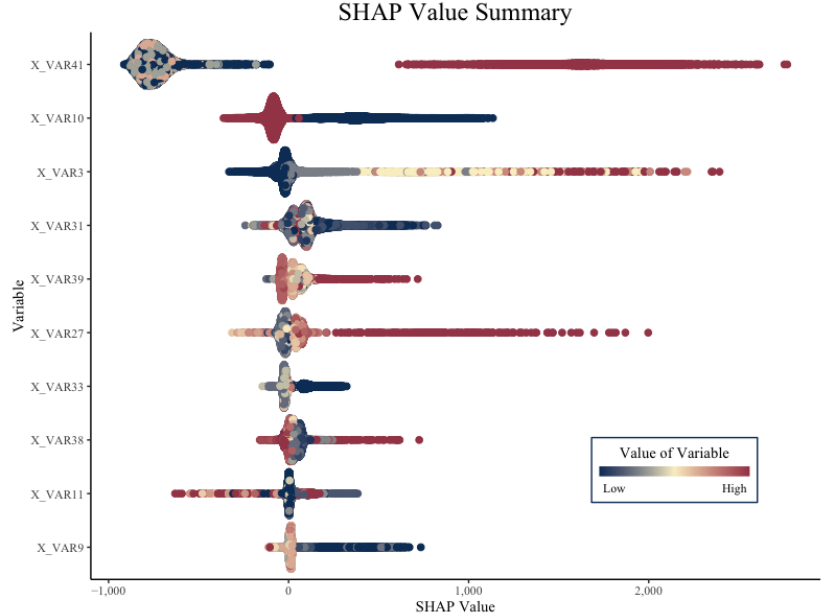
Figure 23. A summary of mSHAP values from 50,000 observations in the COLL test dataset. The 10 most important variables are shown with a beeswarm plot corresponding to the estimated SHAP values from the dataset. Color corresponds to the actual value of the variable, not its importance.